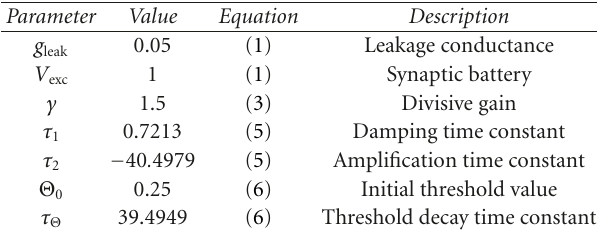
Figure 1: Model sketch : a luminance distribution is subjected to a divisive “gain control” stage #1 ( S ( t ), (3)). At this stage, inhibition of luminance L takes place as a function of increasing photorecep- tor potential P . The second gain control stage G ( t ) can either am- plify the signal S ( t ) or attenuate it ((4), (5), and (6)). Amplification of S ( t ) occurs if the membrane potential P falls below a threshold Θ , and attenuation for P > Θ (see (5)). Both “gain control” stages interact multiplicatively (denoted by the symbol “ ⊗ ,” (2)) before providing excitatory input into the photoreceptor’s membrane po- tential (symbol “ P ,” (1)). The photoreceptor potential in turn feeds back into both of the “gain control” stages. At the same time, the photoreceptor potential represents the output of our model. Table 2: Simulation details : the table is self-explanatory. For the in- tegration of (1), a fourth-order Runge-Kutta scheme was used with an integration time step of 0.01. The remaining di ff erential equa- tions were integrated with Euler’s method with an integration time step of one. Notice that the integration step sizes were not adjusted to match physiological time scales.